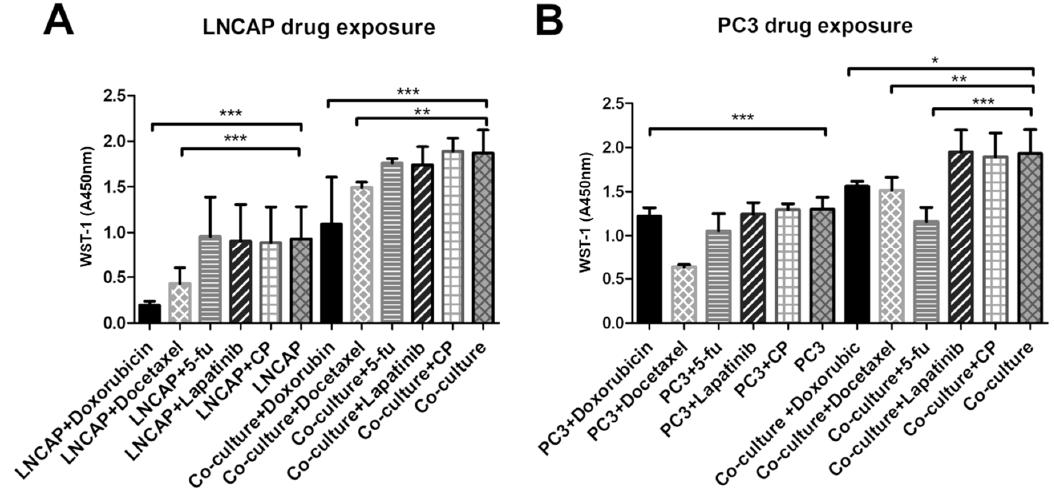
Figure 4. Viability of ( A ) LNCAP and ( B ) PC3 after exposure to five cancer drugs on plastic versus vasculature platform. Results are obtained from 3 biological replicates (n = 3). Each sample contained total RNA from 6 parallel wells. * p < 0.05, ** p < 0.01 and *** p < 0.001. 5-fu = 5-fluorouracil, CP = cyclophosphamide.